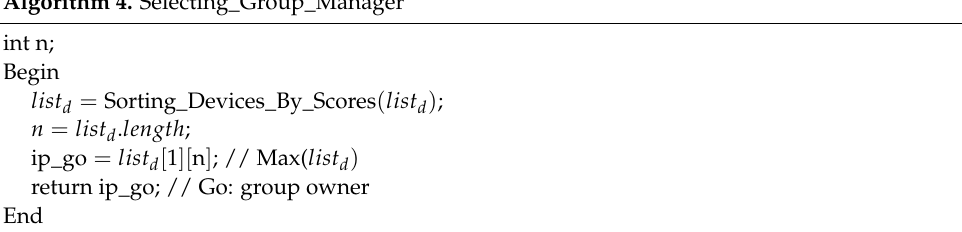
Algorithm 4 to select the group manager: Selecting_Group_Manager: Let us